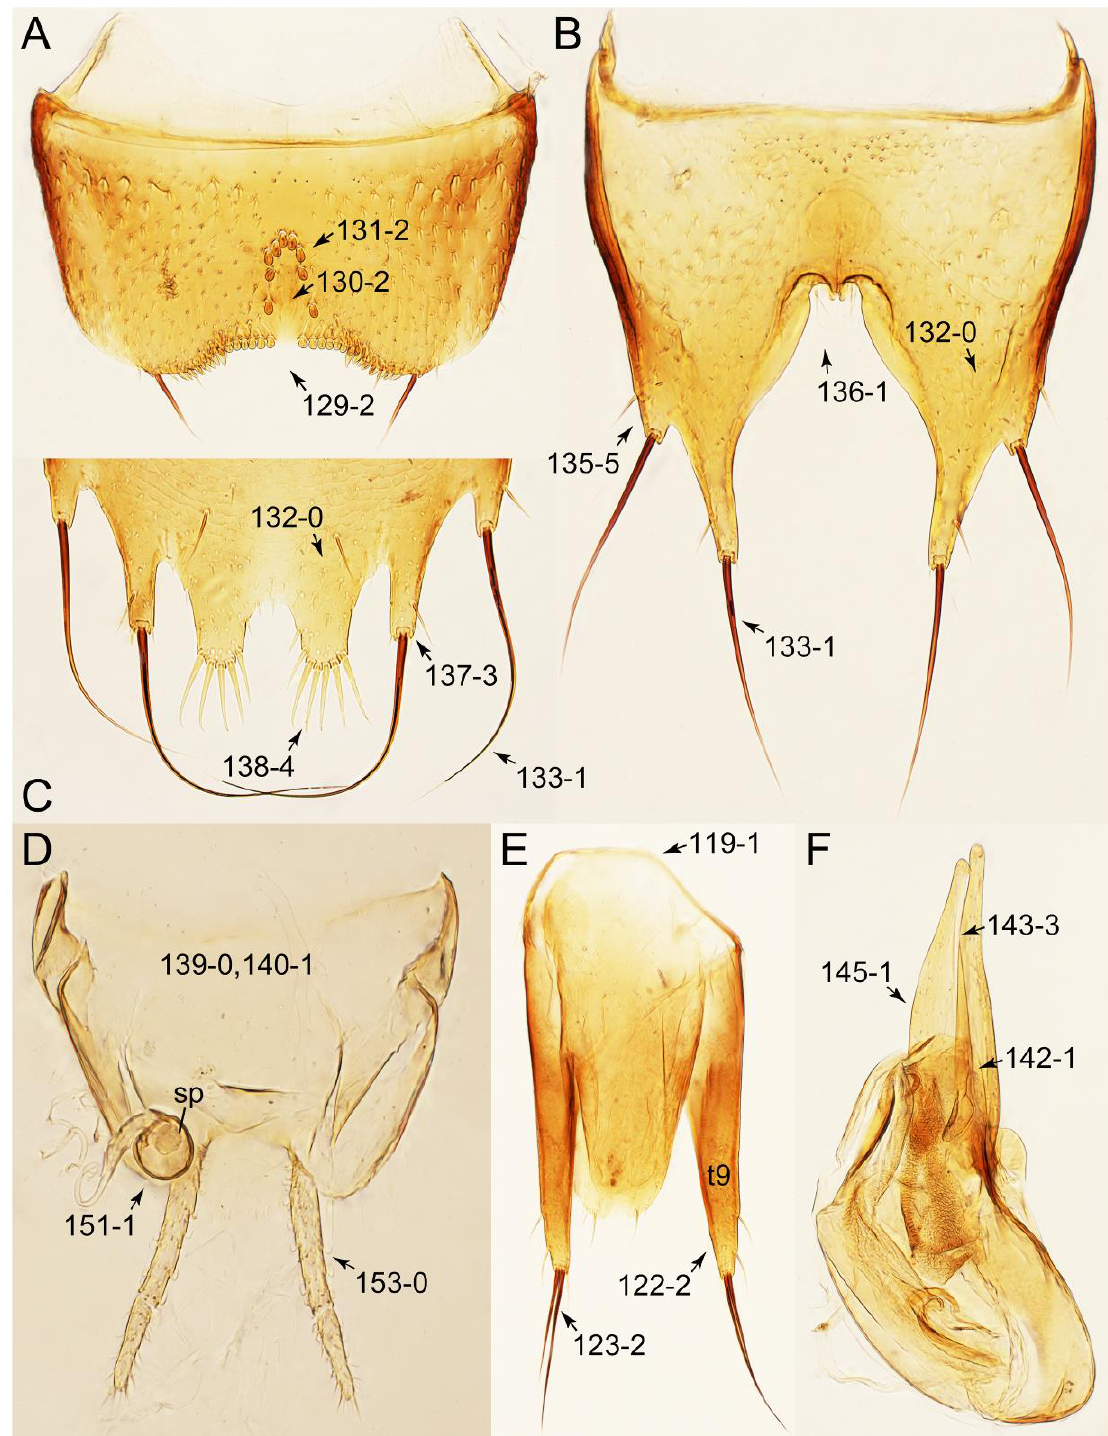
Figure 61. Photographs of body parts of Tachinusini: members of the former Megarthropsini, enlarged. ( A ) male sternite VII of Lacvietina takashii , ventral view. ( B ) male sternite VIII of Lacvietina takashii , ventral view. ( C ) female sternite VIII of Lacvietina takashii , ventral view. ( D ) female genital segments of Lacvietina takashii , ventral view. ( E ) male tergite IX and sternite IX of Lacvietina takashii , dorsal view. ( F ) male aedeagus of Lacvietina takashii , ventrolateral view. Abbreviations: sp, spermatheca; t9, tergite IX. Characters and character states (format X-X) are indicated on each